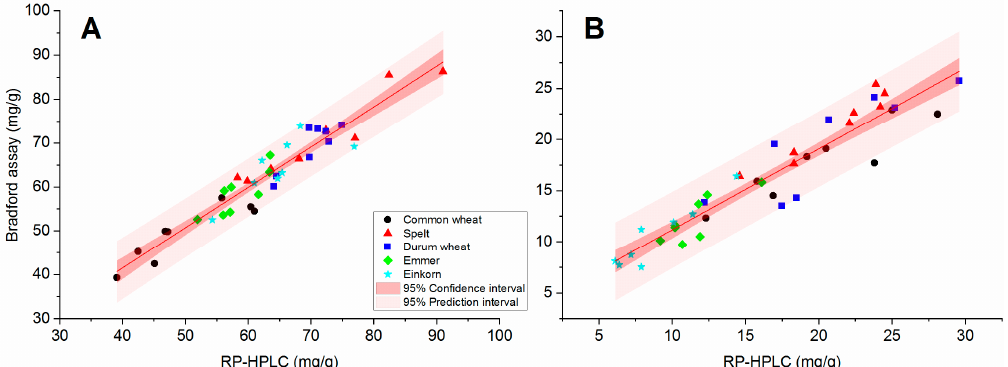
Figure 1. Correlation between RP-HPLC and Bradford assay for the quantitation of gliadins ( A ) and glutenins ( B ) in eight cultivars each of common wheat, durum wheat, spelt, emmer and einkorn.